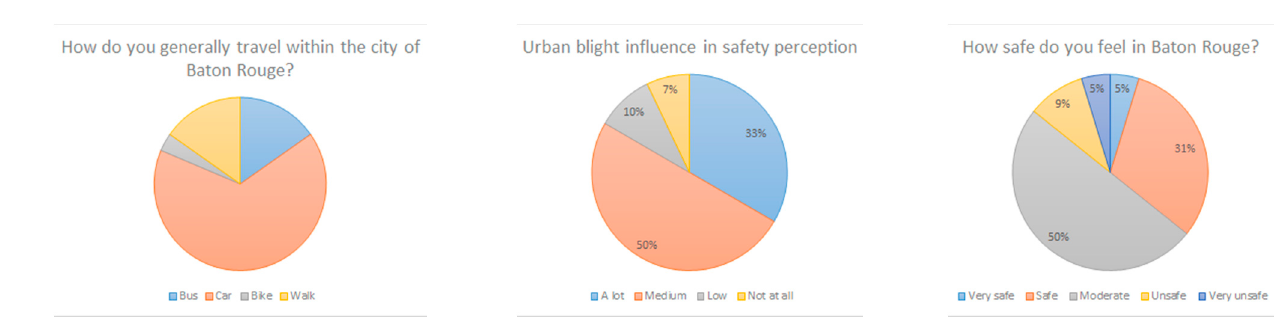
Figure 8. Participants’ general mode of travel (left); the influence of urban blight on safety perception (middle), and feeling of safety in Baton Rouge, USA (right).